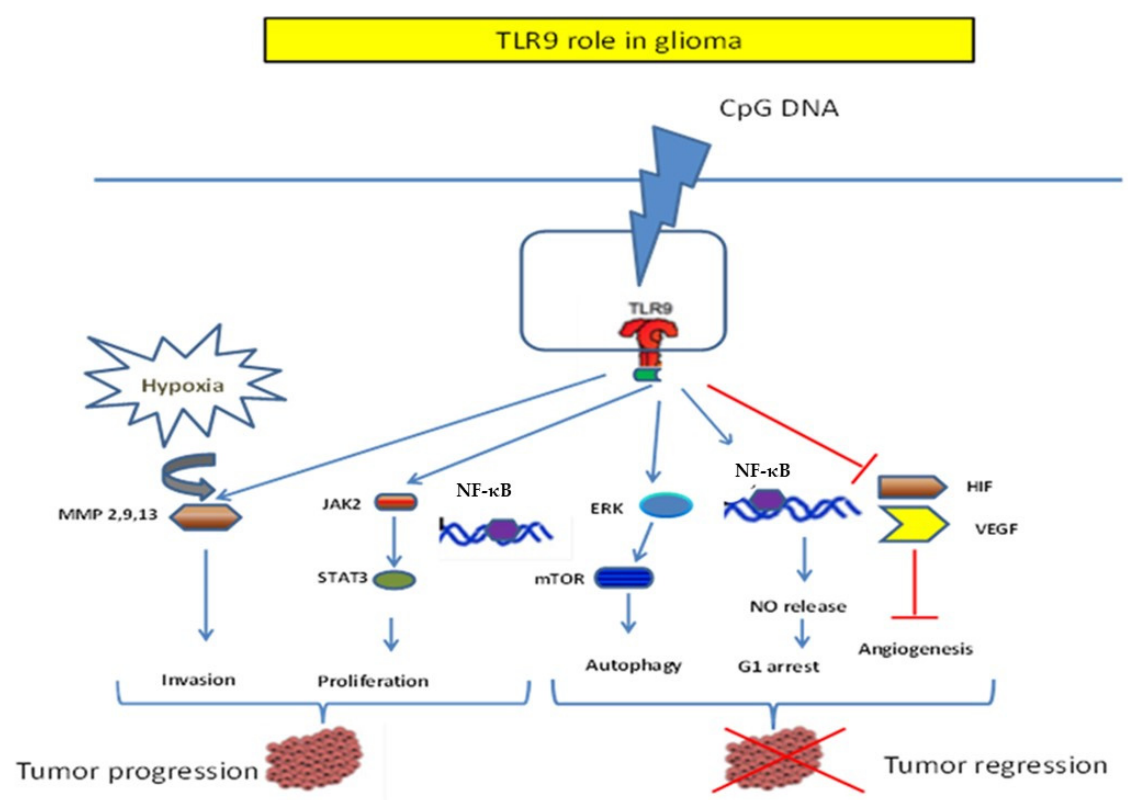
Figure 3. Dichotomic role of TLR9 in Glioma. The role of TLR9 in Glioma on one hand could have an antitumor effect. In fact, TLR9 agonists induce inhibition of angiogenesis by inhibition of VEGF and HIF secretion, inducing G1 arrest of the cell cycle through NF- κ B pathway. On the other hand, TLR9 has a dark side, leading to tumor progression mediated through the activation of the JAK2 and STAT3 transcription factor TLR9 mediate CpG oligonucleotide-induced cellular invasion by increasing the matrix metalloproteinase MMP2, 9, and 13 levels through hypoxia.